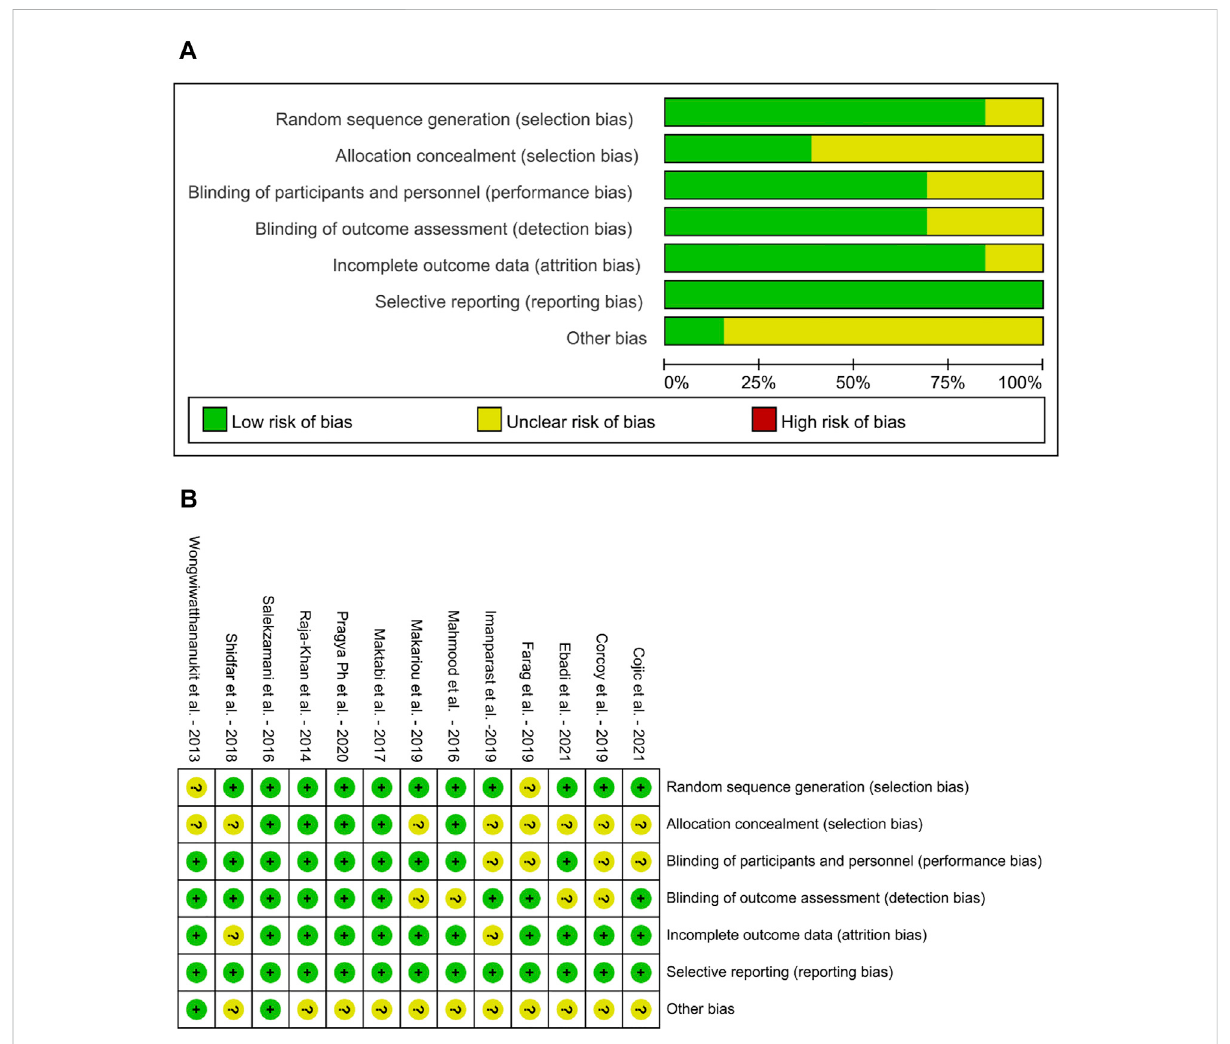
FIGURE 2 Risk of bias graph of Included Studies (A) Risk of bias graph (B) Risk of bias